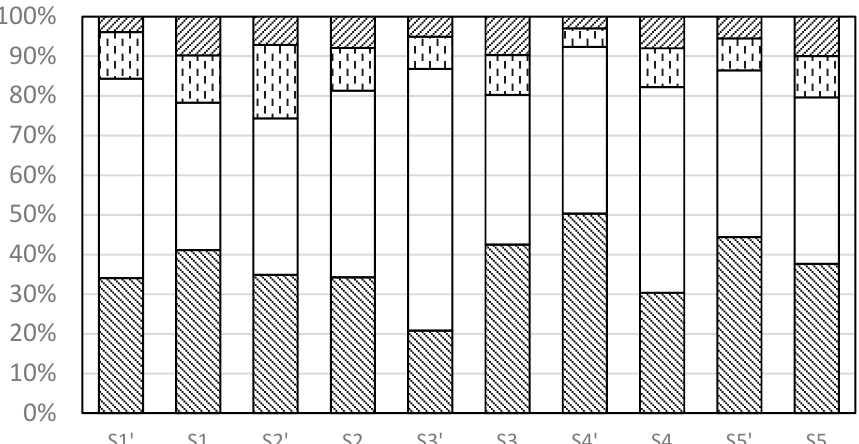
Figure 3. The specific gravity of different ring number PAHs at different points.